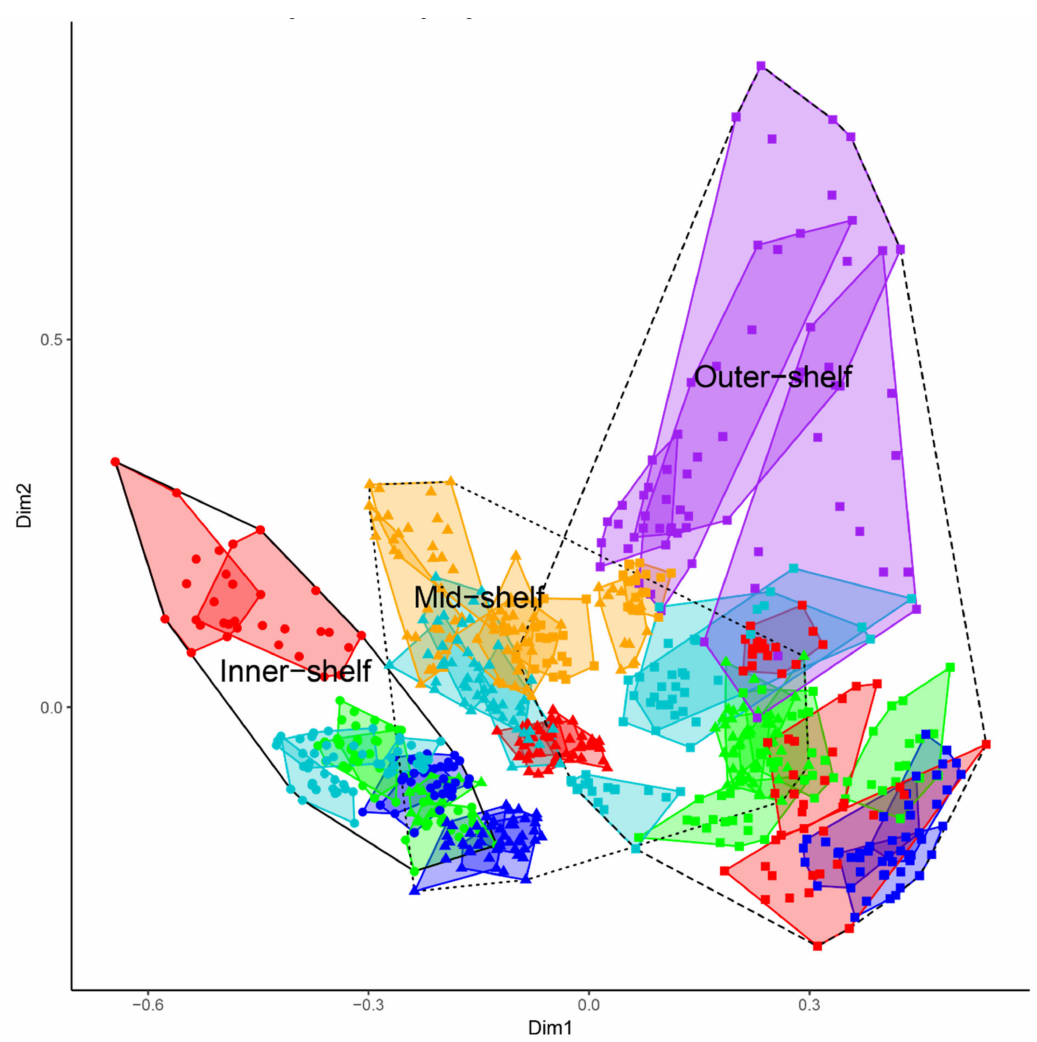
Figure 2. An ordination of a Principle Components Analysis showing the variation in planktivorous damselfish assemblages among sectors, shelf and year. Each data point is the average community composition at a given reef in a given year. Circles are inshore reefs, triangles are mid-shelf and squares are outer-shelf reefs, and grey convex hulls encapsulate all reefs among shelf positions. Data are coloured by latitudinal sector: CL = blue; CA = green; TO = red; WH = yellow; SW = orange; CB = purple. Individual reefs are bounded by coloured